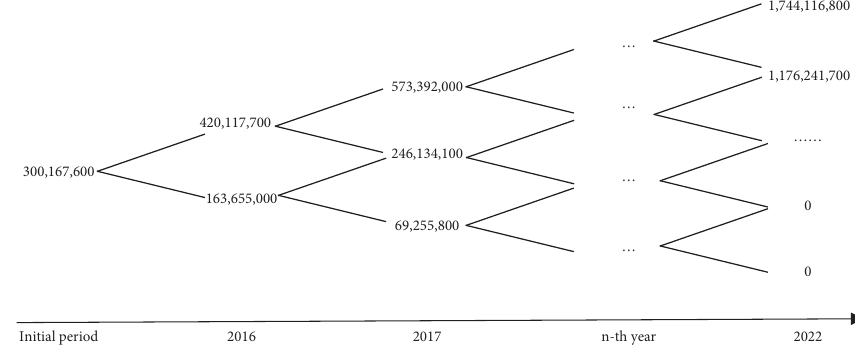
Figure 3: Real option value distribution of tourism real estate project (unit: yuan).